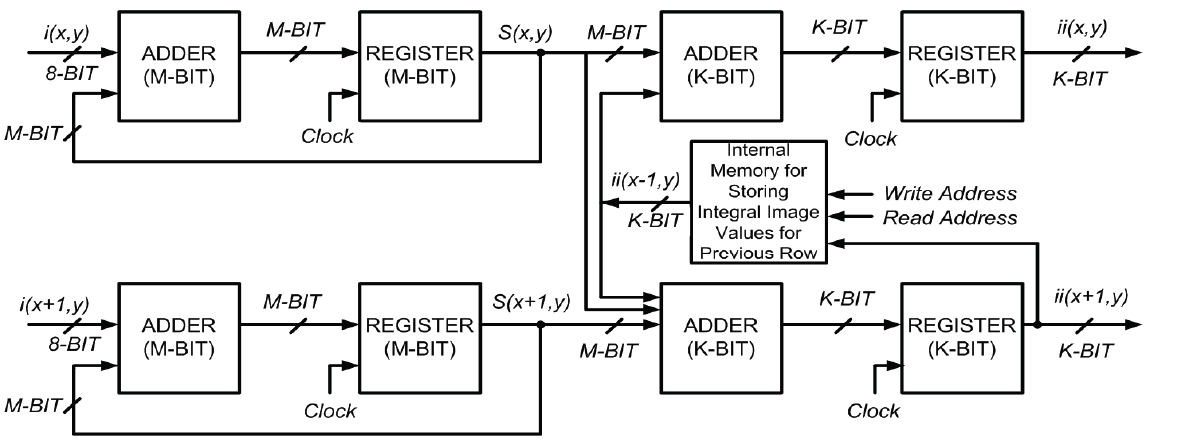
Figure 5. Block diagram of the proposed architecture for parallel computation of integral image for 2